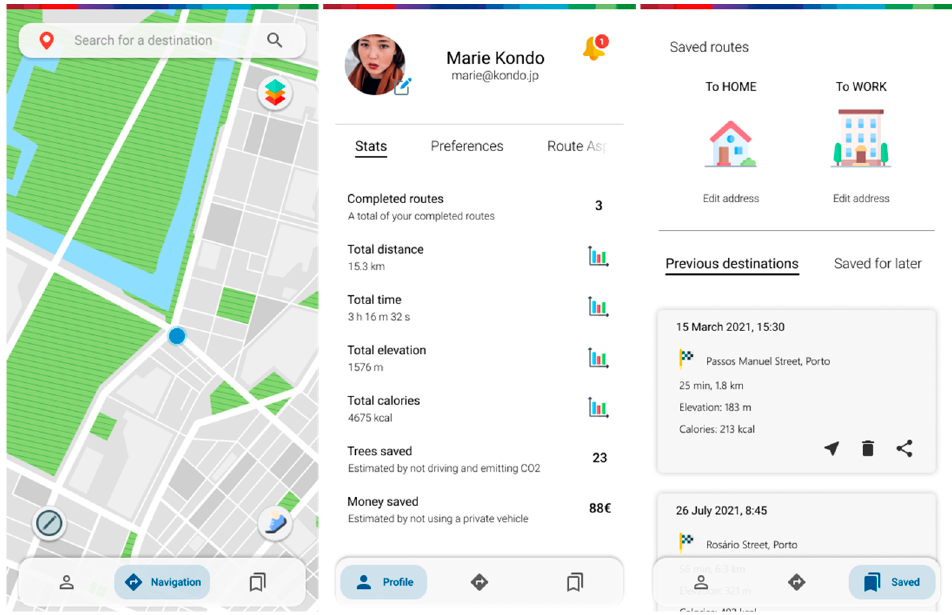
Figure 9. Home screen, profile section, and previously saved locations section.